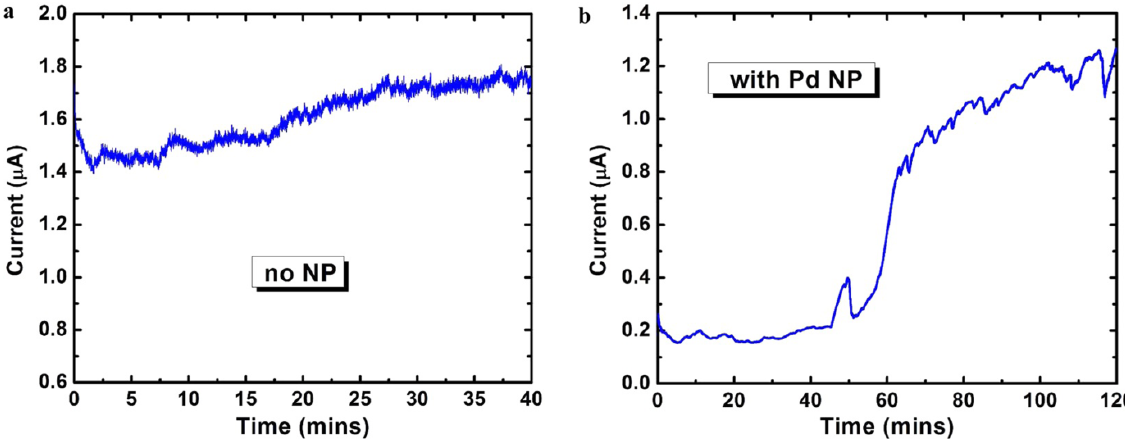
Figure 10. ( a ) Real-time measurement of current of MoS 2 FET without any NPs. Thickness of MoS 2 used was around 8 nm; ( b ) Real-time measurement of current of the same MoS 2 FET after incorporation of Pd NPs. Current increases substantially upon exposure to hydrogen (3 ppm from time = 45 min onwards) from 0.2 μ A to about 1 μ A. Reprinted with permission from Ref. [156]. Copyright, 2015, American Chemical